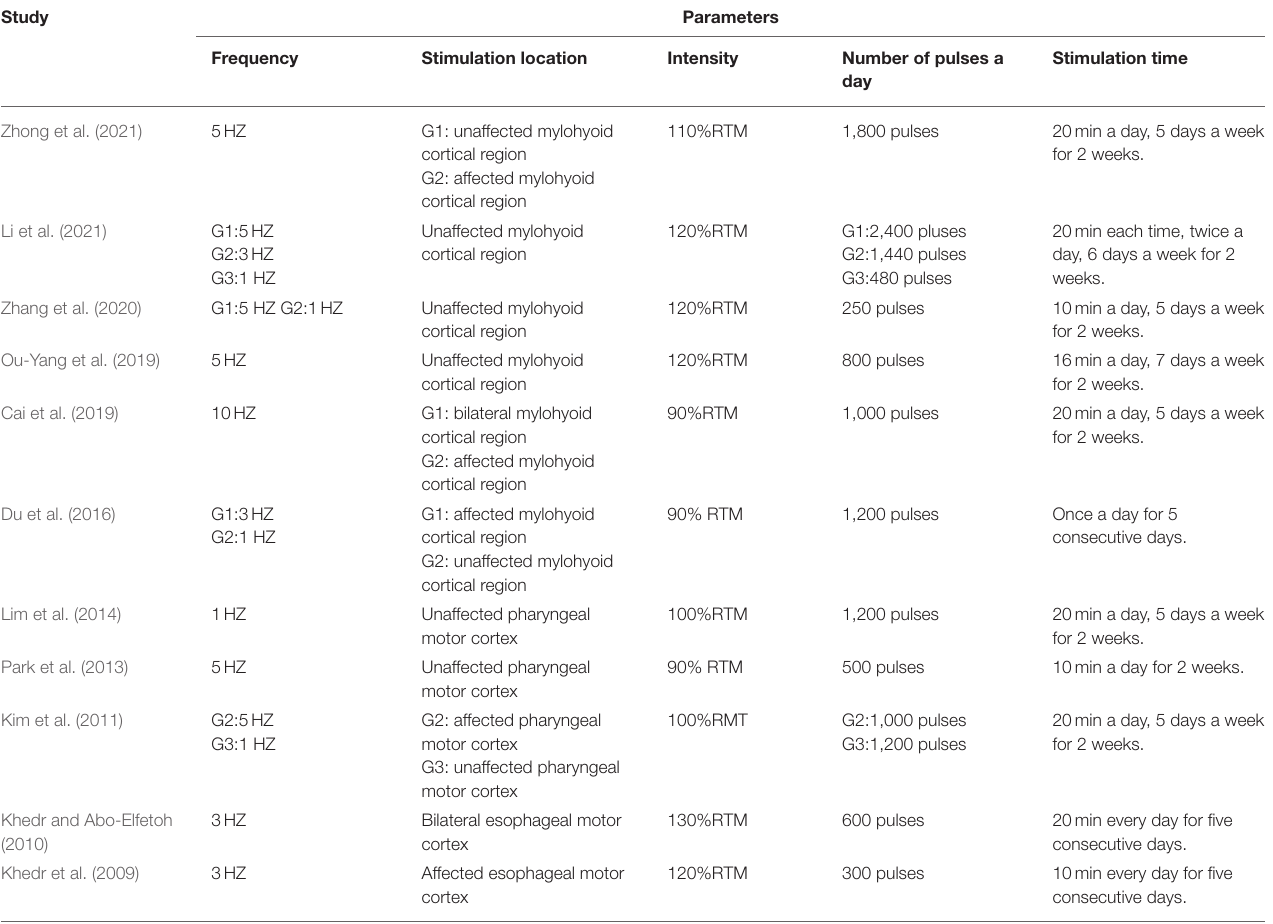
TABLE 3 | Main parameters of rTMS.